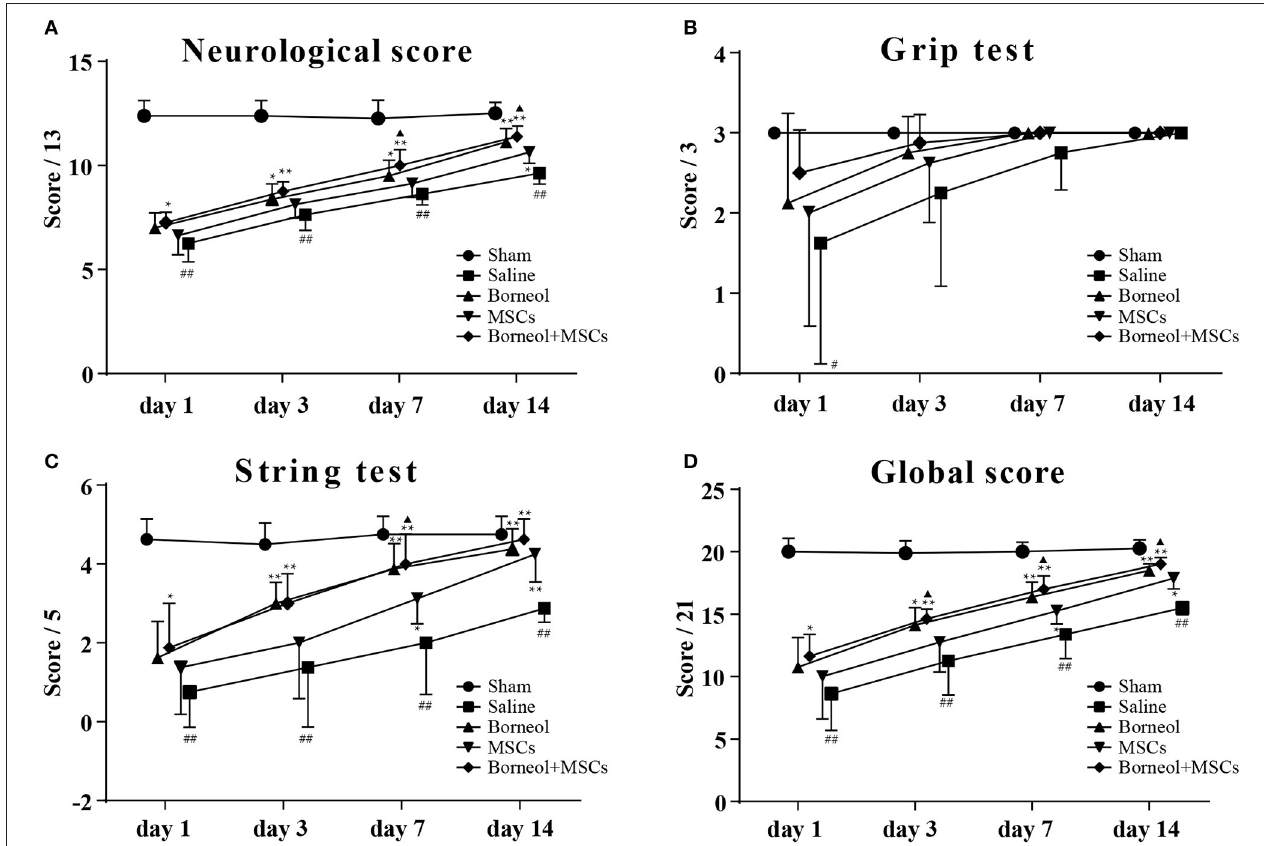
FIGURE 3 | Effect of borneol and MSCs transplantation on neurological deficits. At 1, 3, 7, and 14 d after MSCs transplantation, neulogical deficits were evaluated by (A) the neurological score, (B) the grip test, (C) the string test and (D) the global score. Data were expressed as mean ± SD . ## P < 0.01 compared with sham group; * P < 0.05, ** P < 0.01 compared with MCAO plus saline group; N P < 0.05, compared with MSCs